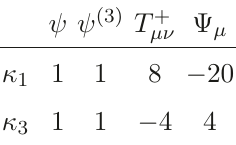
4(2a c) for the 2 unitary and − −